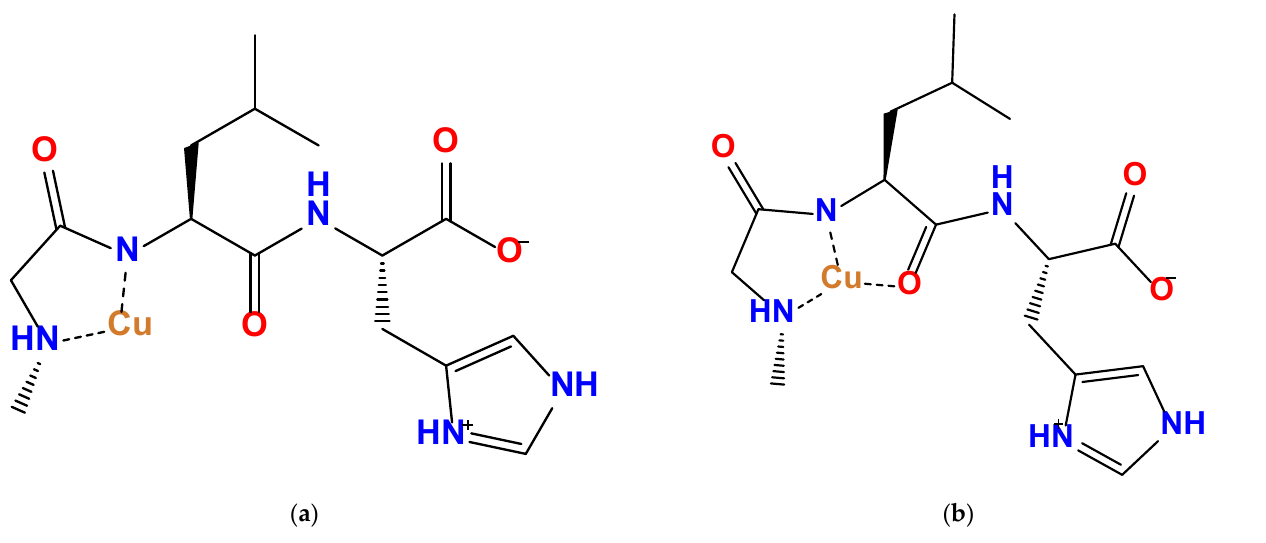
Figure 3. The two coordination modes ( a ) with an amine-N and neighboring amide-N coordination and ( b ) with an amine-N, neighboring amide-N and carbonyl-O coordination for the ML species of Sar-LH.